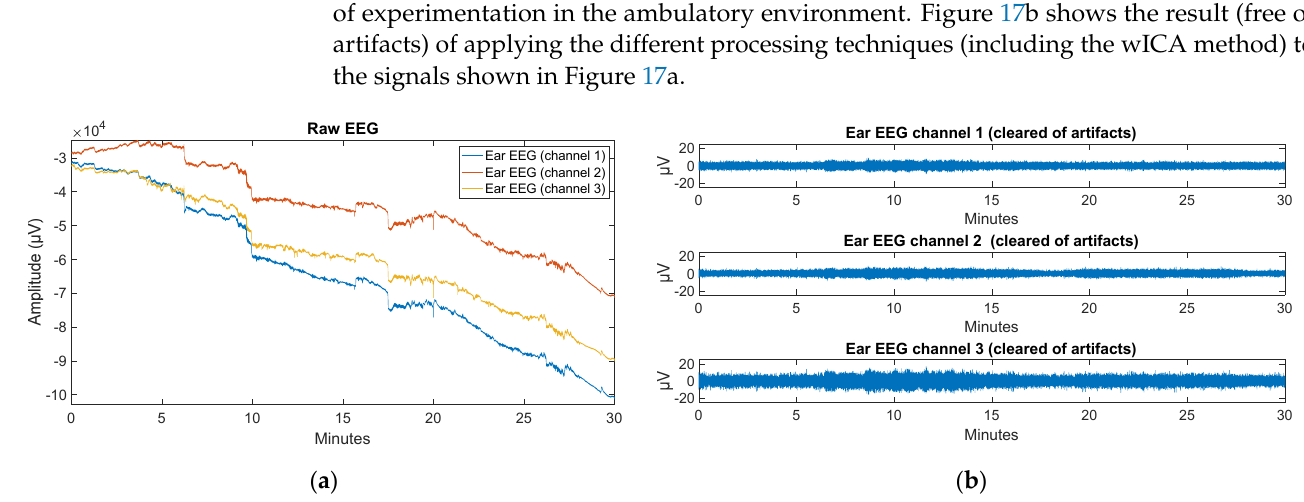
Figure 17. ( a ) Raw ear EEG signals; ( b ) Artifact ‐ free ear EEG signals.